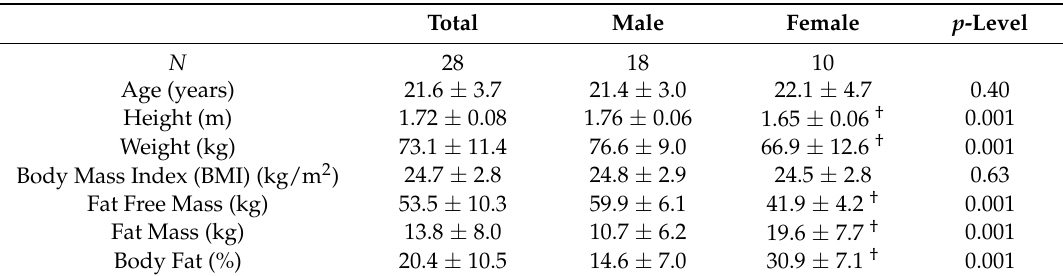
Table 1. Participant